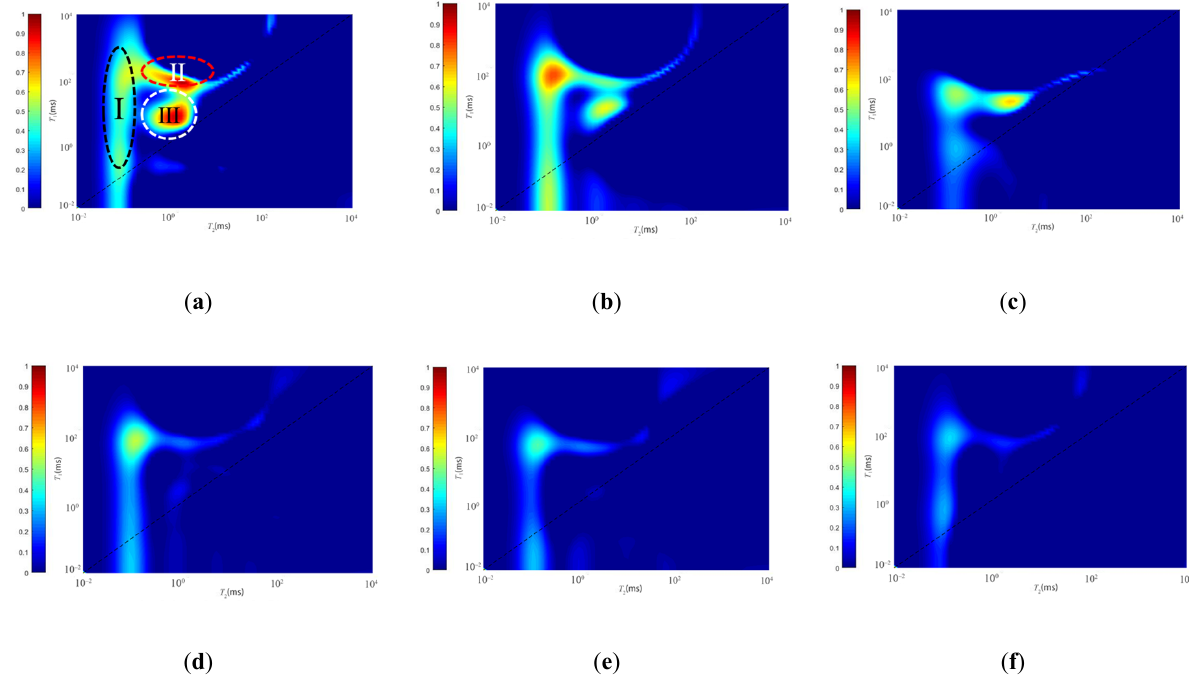
Figure 9. Multi-temperature state 2D T 1 - T 2 maps for inter-salt shale powder sample ZY1-1. ( a ) Original state, ( b – f ) different temperature states of 80, 200, 350, 450, and 600 °C, respectively.